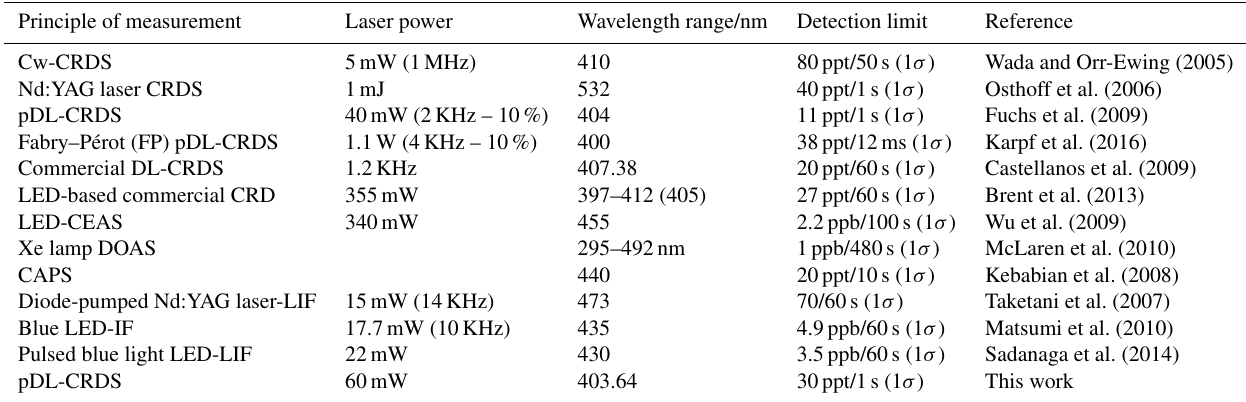
Table 1. Comparison of NO 2 detection limits based on optical methods.